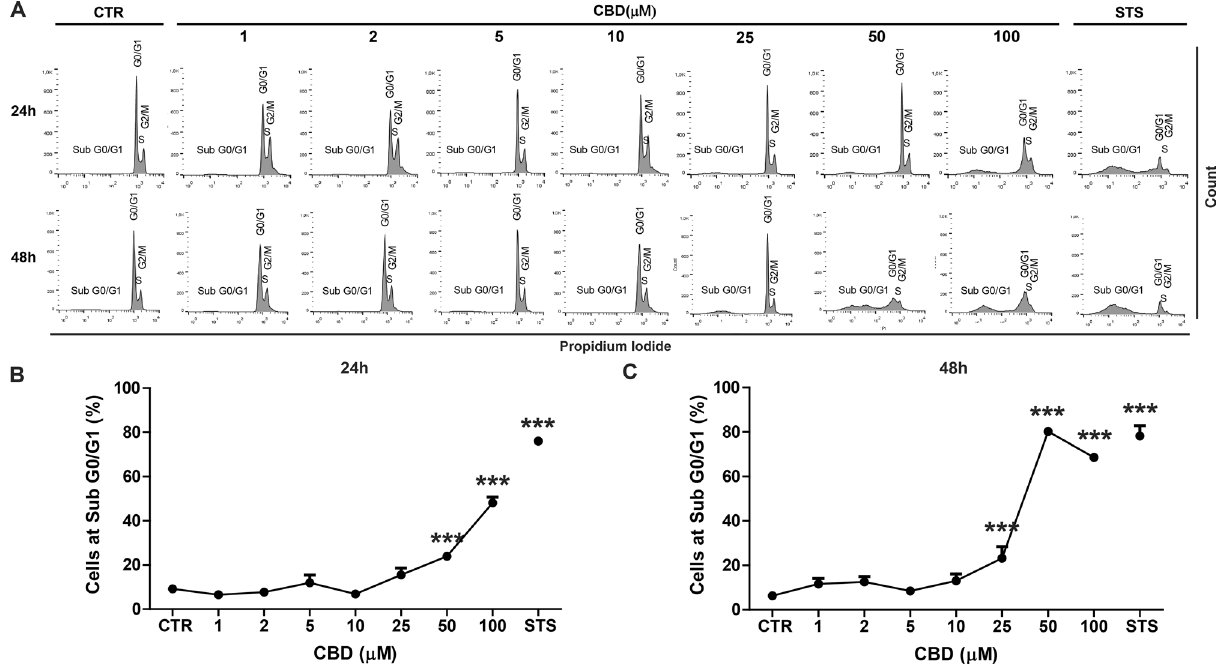
Figure 1. CBD modulates cell death in a concentration and time-dependent manner. SH-SY5Y cells were treated with different CBD concentrations and assessed using the Propidium Iodide cell cycle assay. ( A ) Representative histogram of the sub-G 0/ G 1 population (an indicative of cell death) of untreated cells (CTR), cells treated with 1, 2, 5, 10, 25, 50 or 100 µM of CBD and 1 µM of staurosporine (STS) for 24 and 48 h. ( B ) The percentage of SH-SY5Y cells in the sub-G 0/ G 1 phase of the cell cycle after 24 h of treatment with the different CBD concentrations. The results showed that 50 and 100 µM of CBD increased the percentage of cells in the sub-G 0/ G 1 phase. ( C ) The percentage of SH-SY5Y cells in the sub-G 0/ G 1 phase of the cell cycle after 48 h of treatment with the different CBD concentrations. The results showed that 25, 50 and 100 µM of CBD increased the percentage of cells in the sub-G 0/ G 1 phase. Data are expressed as the mean ± S.E.M. Two-way ANOVA ( F 8,88 = 22.764) followed by Dunnett’s post-hoc test; *** p < 0.001 relative to the CTR